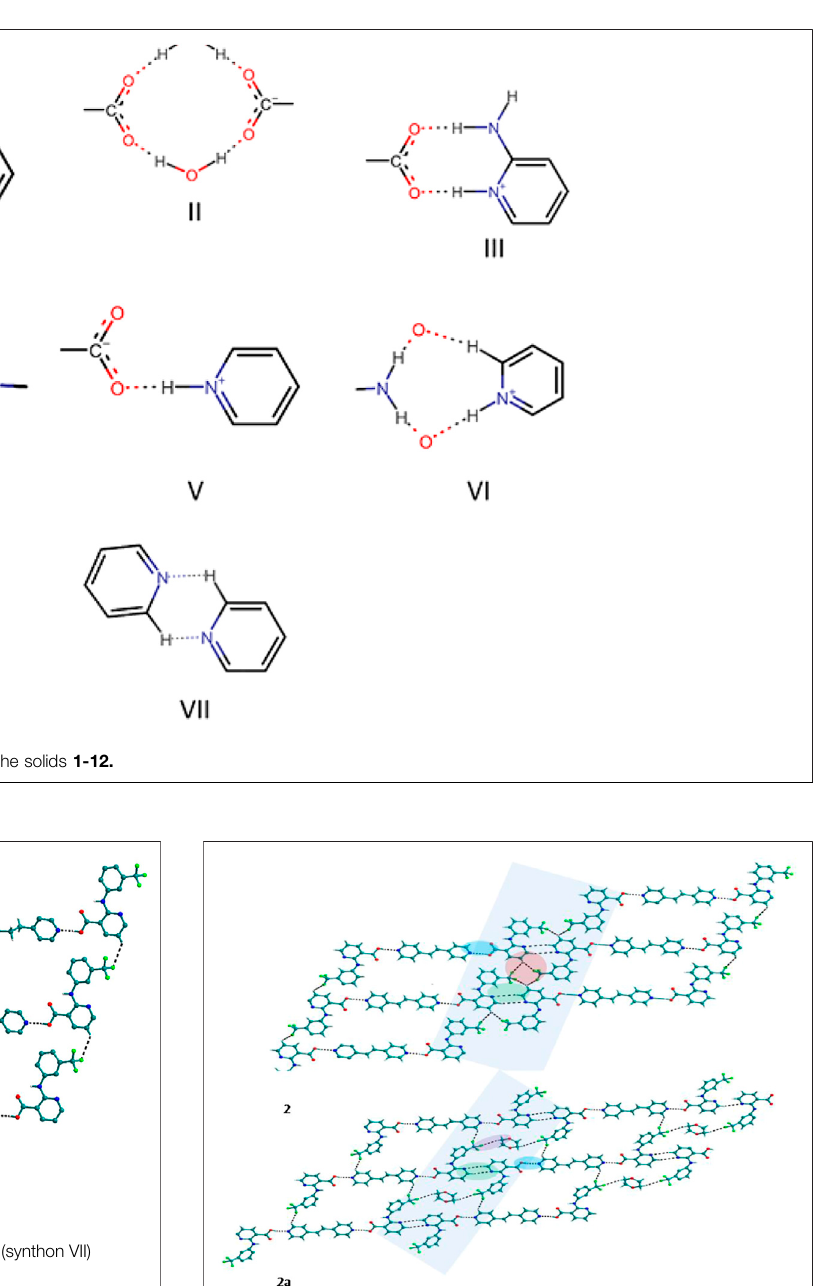
Frontiers in Chemistry |